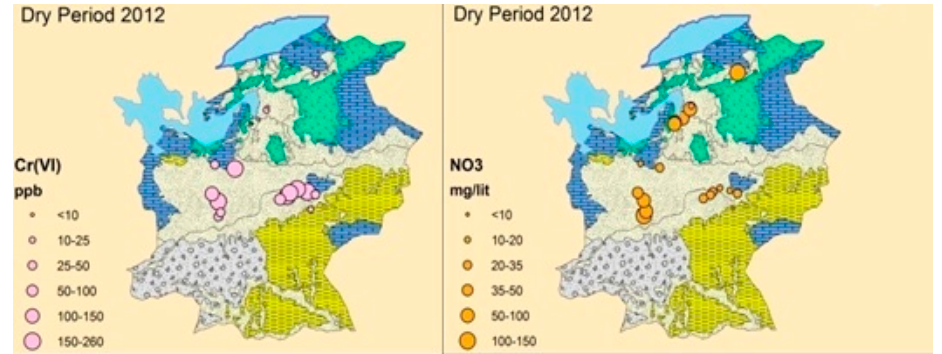
Figure 6. Cr (VI) and NO 3 − concentrations in the polluted areas of Thebes.